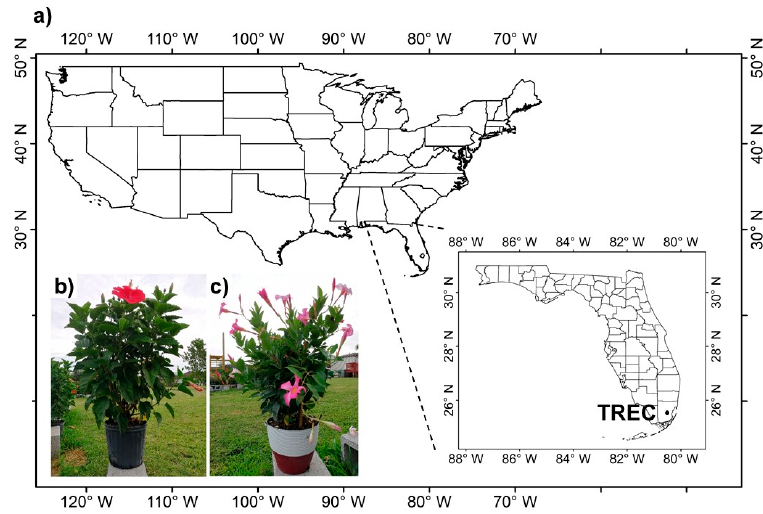
Figure 1. Location of the experiment site and crops investigated in this study. ( a ) The location of the Tropical Research and Education Center (TREC), University of Florida, Homestead, Florida; ( b ) H. rosa ‐ sinensis ; ( c ) M. splendens .